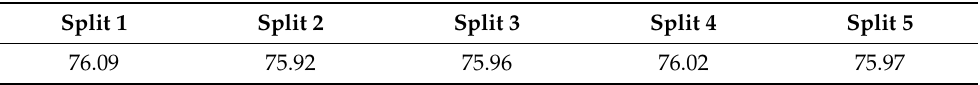
Table 8. Experiment on sensitivity analysis. Split 1, 2, 3, 4 and 5 are random labeled data splits under labeling rate 5%. The best accuracy (%) of each split is